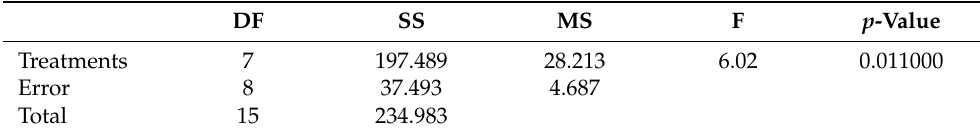
Table 3. ANOVA for surfactant screening.